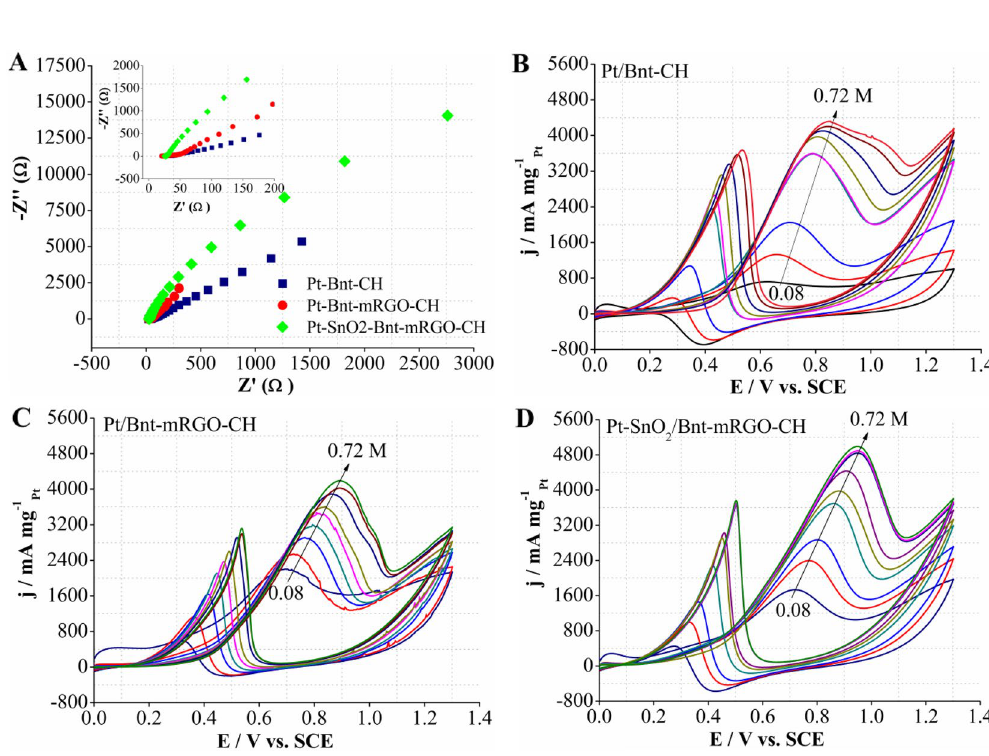
Figure 5. ( A ) Nyquist plots of the catalysts for MOR in 0.5 M H 2 SO 4 and 0.72 M methanol, CV curves on ( B ) Pt/Bnt-CH, ( C ) Pt/Bnt-mRGO-CH and ( D ) Pt-SnO 2 /Bnt-mRGO-CH in 0.5 M H 2 SO 4 and different concentration of methanol 0.08, 0.16, 0.24, 0.32, 0.41, 0.48, 0.56, 0.64 and 0.72